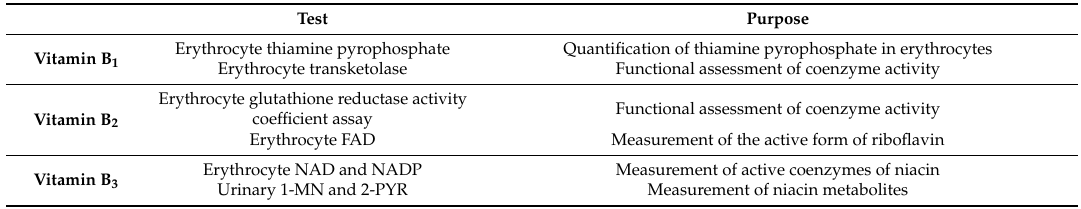
Table 2. Tests and their respective purposes of commonly used methods used to assess micronutrient